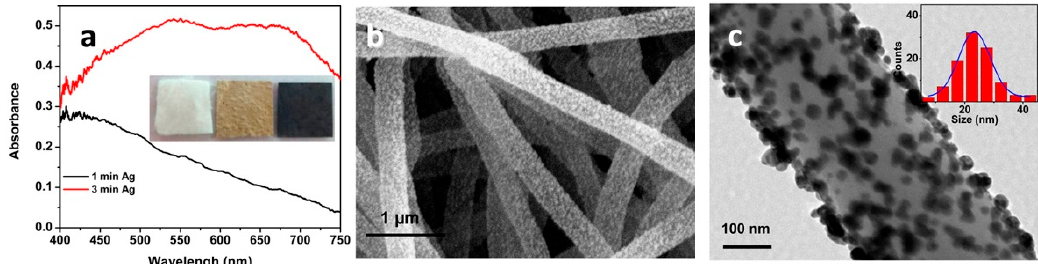
Figure 27. ( a ) Reflectance spectra of the nanofibers decorated with silver nanoparticles after 1- and 3-min immersion in the Tollen’s reactive. In the inset, from left to right: Macroscopic images of the polyacrylonitrile (PAN) fibers, bare, functionalized with amidoxime, and functionalized with silver nanoparticles. ( b ) Representative SEM image of the fibers after the electroless plating step. ( c ) Representative transmission electron microscopy (TEM) image of the fibers after the electroless plating step. In the inset, size distribution of the nanoparticles. Reproduced with permission from Zhang et al. [341]. Copyright (2012), American Chemical